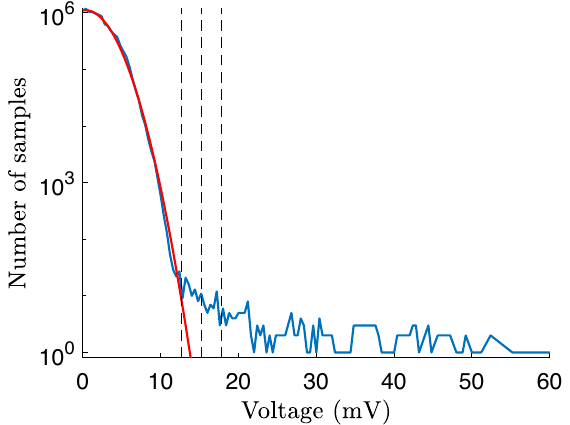
FIG. 9. Frequency histogram of the measured dark current signal values in one window, measured at an electric field of 29 . 2 MV = m, in measurement series D. The histogram contains 150 evenly spaced bins, each 0.4 mV (corresponding to a current of 2 . 3 × 10 7 μ A) wide. The vertical dashed lines represent deviations from the mean of 5 σ , 6 σ , and 7 σ .